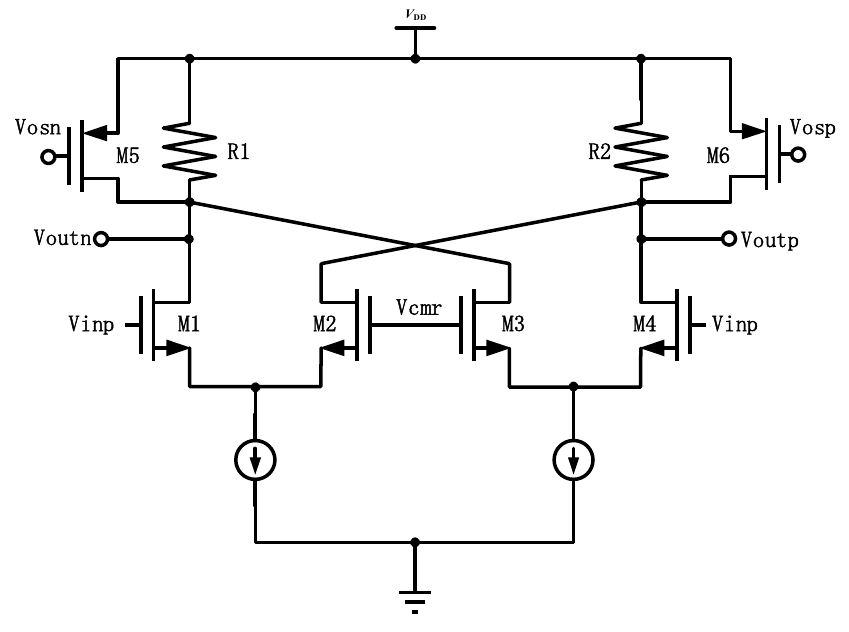
Figure 10. DC offset cancellation (DCOC) schematic. Figure 10. DC o ff set cancellation (DCOC)